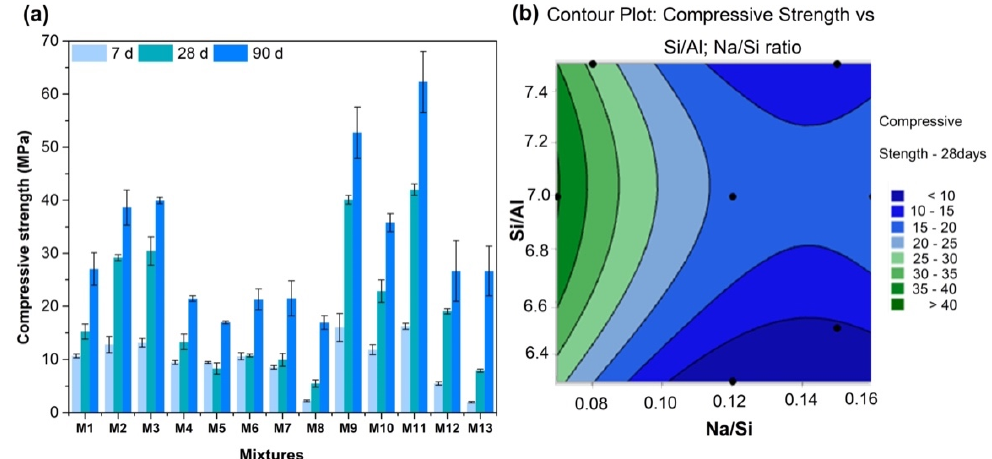
Figure 2. ( a ) Compressive strength at ages of 7, 28, and 90 days for cements 85%CW − 15%OPC. ( b ) Contour statistic plots.